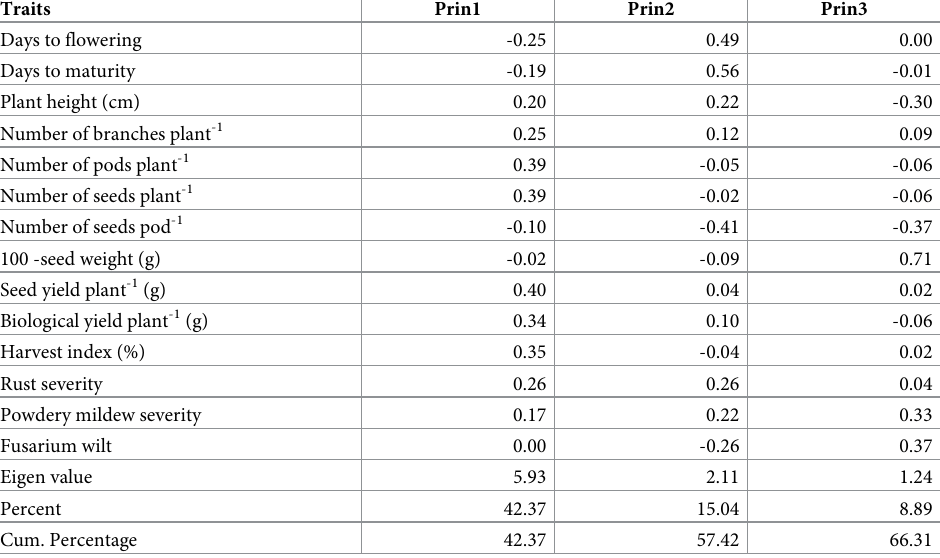
Table 3. Eigen vectors, eigenvalues, individual and cumulative percentages of variation explained by the first three principal components (PC) of wild lentil accessions. Traits